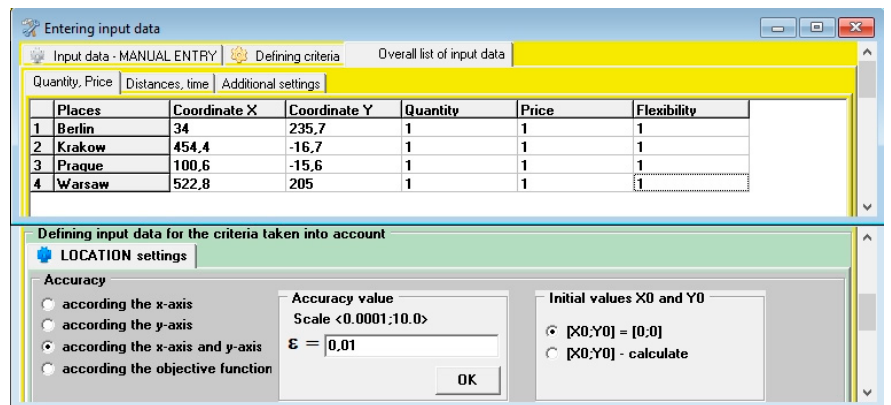
Figure 11. Input data and calculation settings for calculating the optimal point location on the surface based on Table 1.